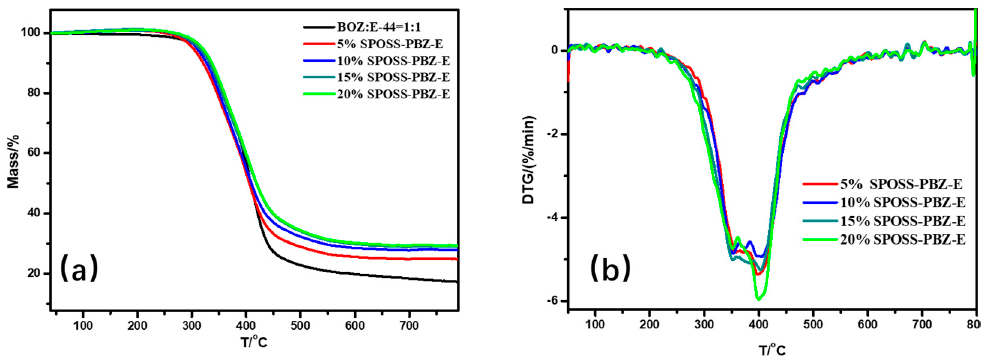
Figure 10. ( a ) TG and ( b ) DTG curves of the SPOSS-PBZ-E nanocomposites under N 2 atmosphere.